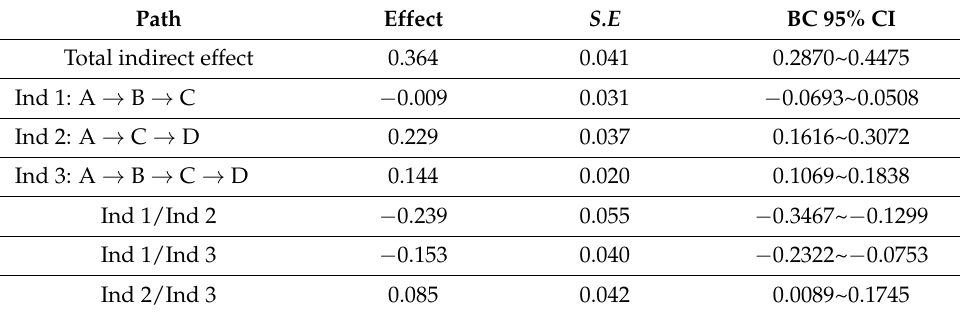
Table 4. Indirect effects of the mediation